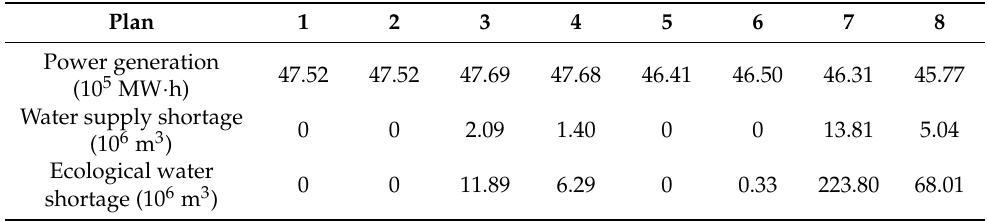
Table 8. The set of typical plans calculated by the